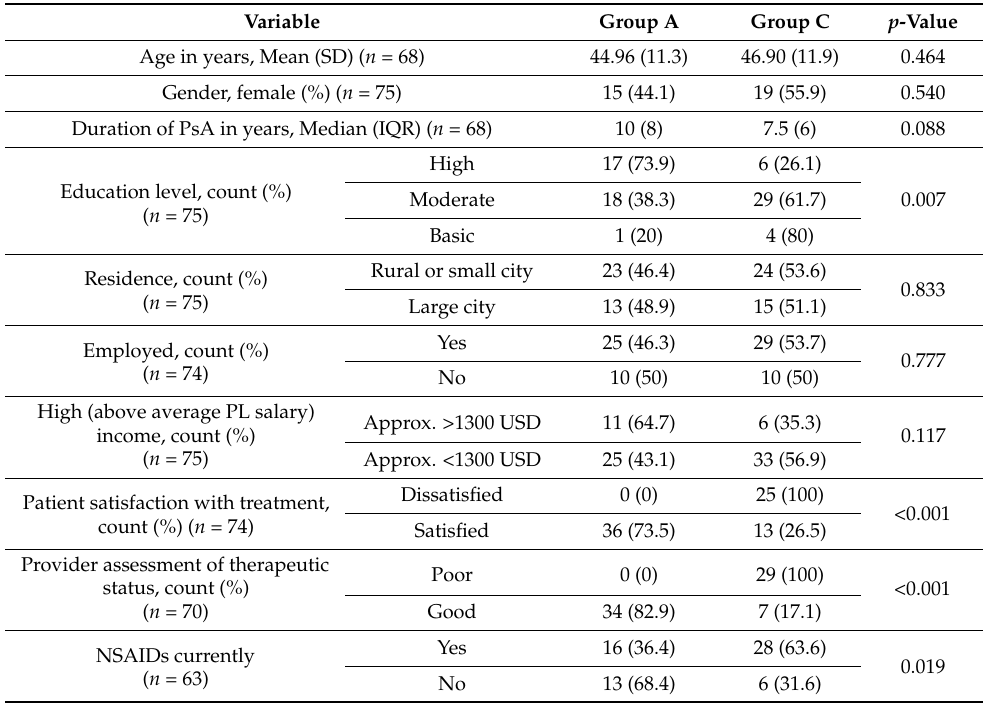
Table 2. Demographic and clinical characteristics of group A (current bDMARD users) and C (bDMARD drug program eligible; did not initiate) patients among the population of inadequate responders with active